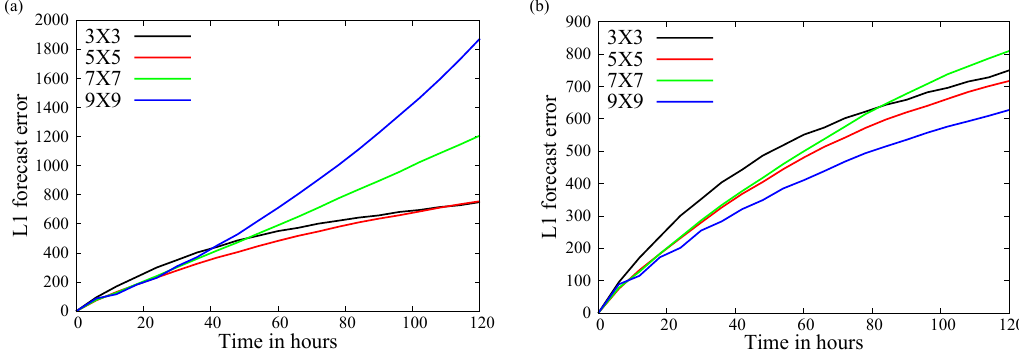
Figure 2. Globally integrated absolute forecast error plotted against time for local NNs with different stencil size. (a) NNs that use local networks with smaller stencil size as well as the special pole network towards the poles. (b) NNs that fix the fields close to the poles to stabilise simulations.